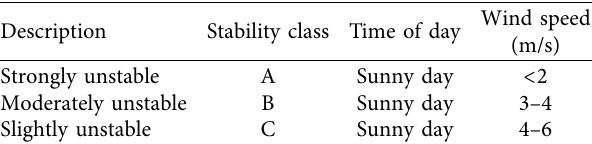
Table 1: The three most selected Pasquill–Gifford stability classes based on the site